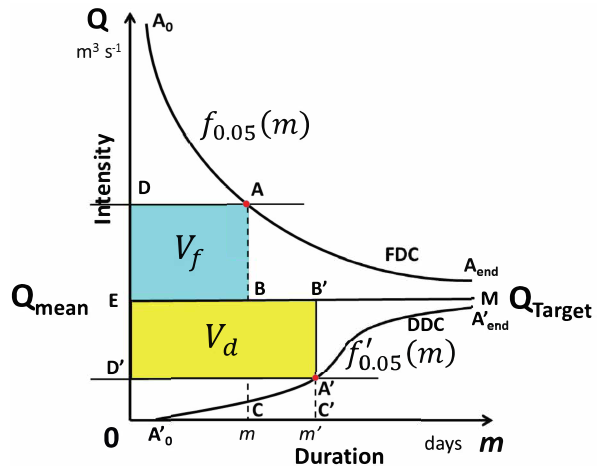
Figure 5. Schematic illustration of how to calculate necessary stor- ages V f and V d to smooth out the hydrological variation to the long- term mean Q mean for flood control and drought